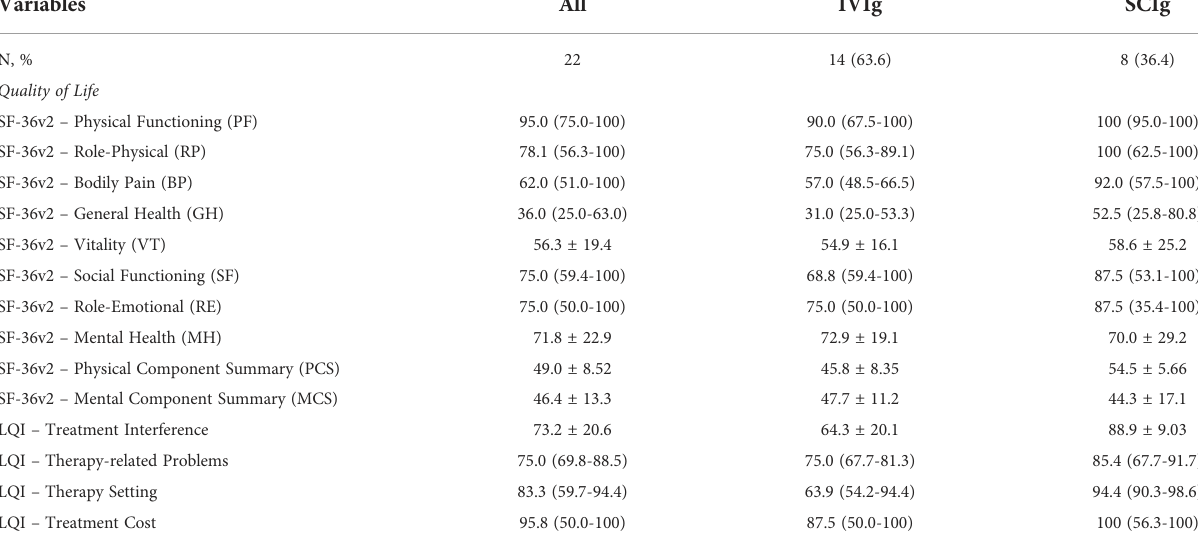
TABLE 3 Health-related quality of life of patients on regular IVIg and SCIg replacement.